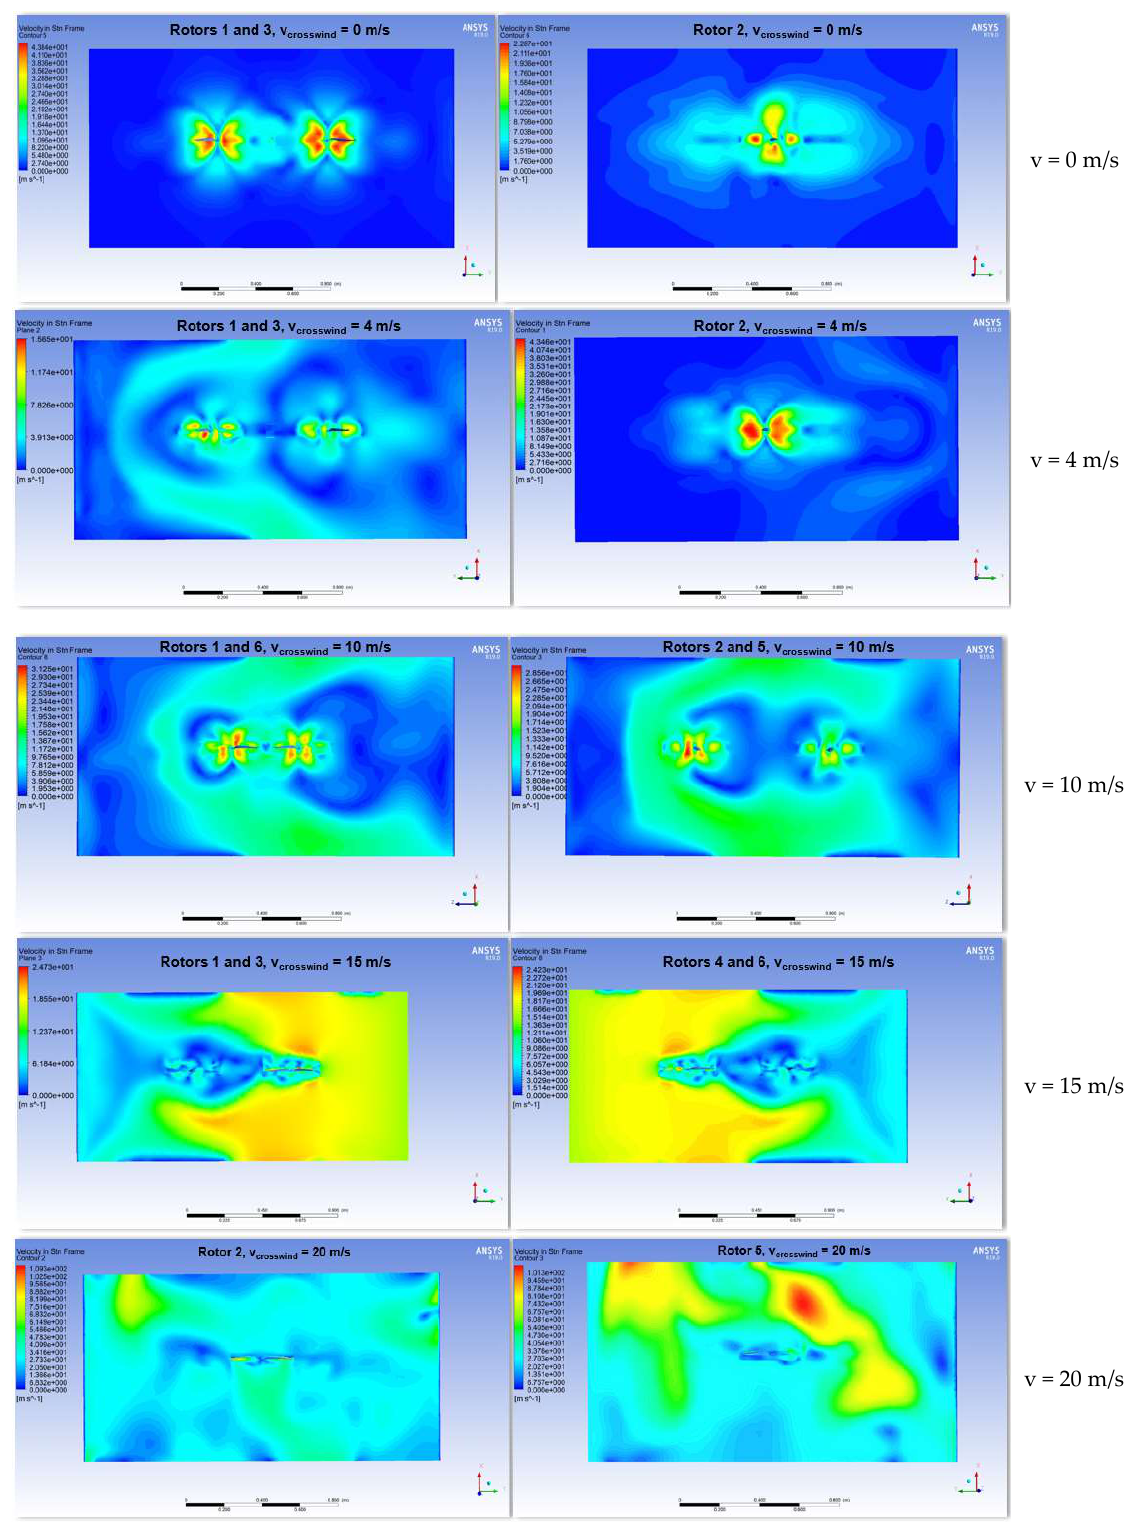
Figure 36. Velocity profile and dissipated turbulences for no wind and lateral wind scenarios.